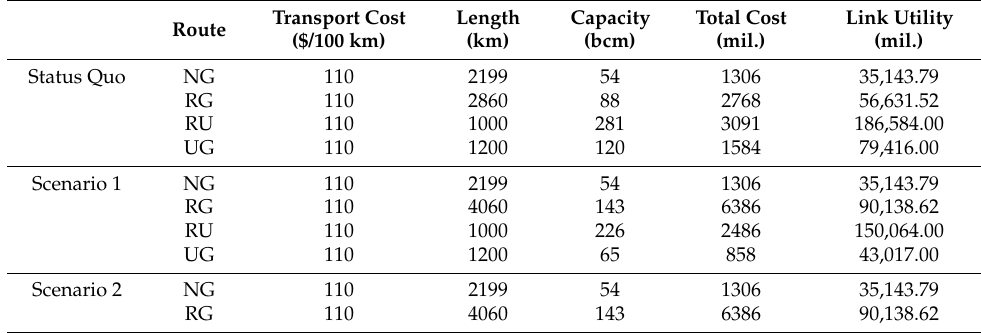
Table 2. Specifications and computation results related to